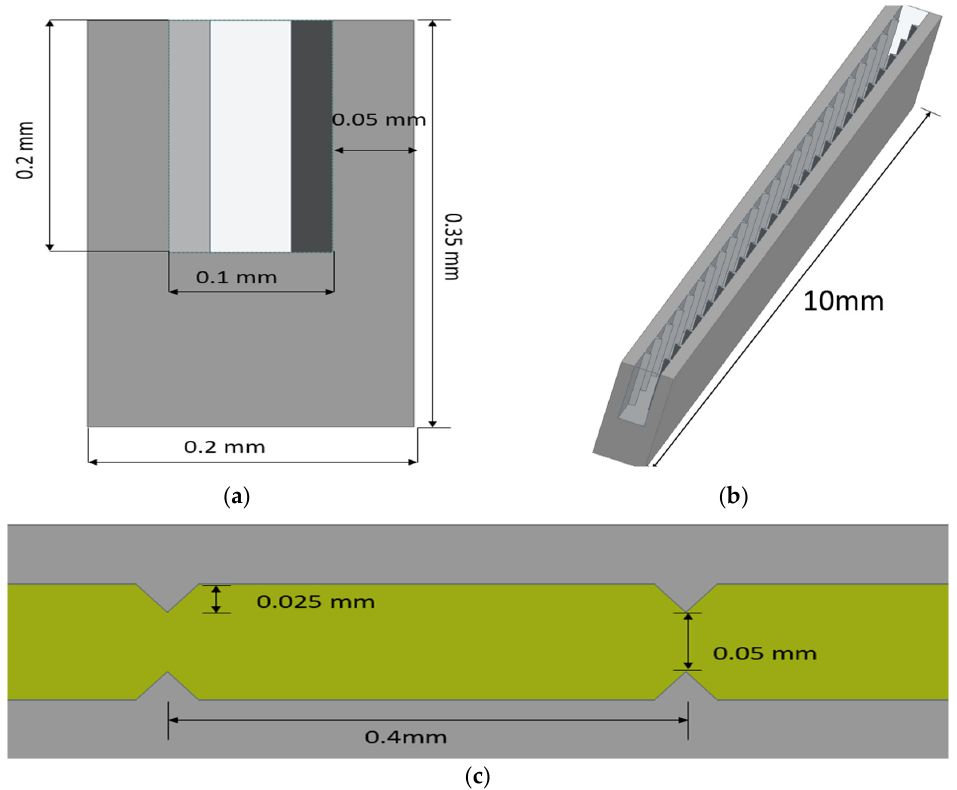
Figure 1. ( a ) Cross-sectional view, ( b ) isometric view, ( c ) top view of single passage of microchannel heat sink.